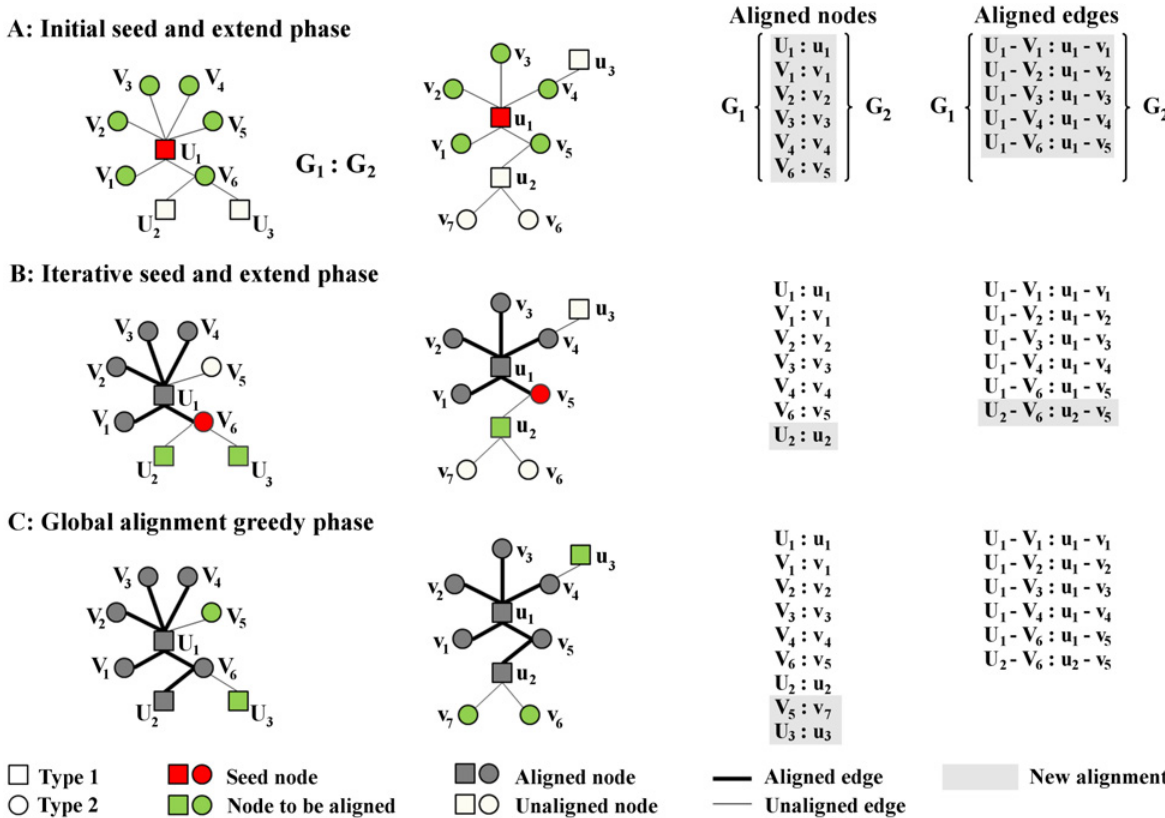
Fig 7. Host-Pathogen Interactions Alignment (HPIA) algorithm. The HPIA algorithm is a seed-and extend algorithm that aligns two bipartite graphs, e.g., two different host-pathogen protein interaction networks. A) Given an initial pair of seed nodes (red nodes U 1 and u 1 ) from two graphs G 1 (left) and G 2 (right), the algorithm first aligns seed nodes to each other. Then, it aligns the neighbors of the seed nodes from the first graph (green nodes V 1 -V 6 ) to the neighbors of the seed nodes in the second graph (green nodes v 1 -v 5 ) based on the node similarity measure (as defined in Equations 6, 8, and 9). This procedure results in six aligned nodes and five aligned edges. B) The algorithm iteratively selects new seeds and extends around them, e.g., it selects nodes V 6 from G 1 and v 5 from G 2 as new seed nodes and, based on the node similarity measure, aligns their unaligned neighbors U 2 to u 2 , creating an additional aligned edge (U 2 -V 6 to u 2 -v 5 ). C) When the algorithm cannot find any seed nodes of the same type that have unaligned neighbors, it greedily aligns all of the remaining unaligned nodes based on their type and the node similarity measure. Some nodes may remain unaligned if the graphs ’ sizes vary, e.g., when there is no match for v 6 from G 2 in G 1 . The HPIA algorithm generates a list of aligned nodes and a list of aligned edges inferred from the aligned